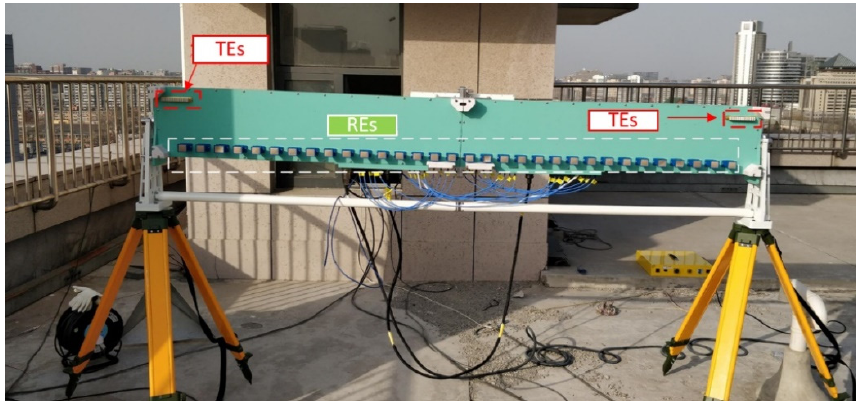
Figure 9. MIMO system utilized in the experiment.